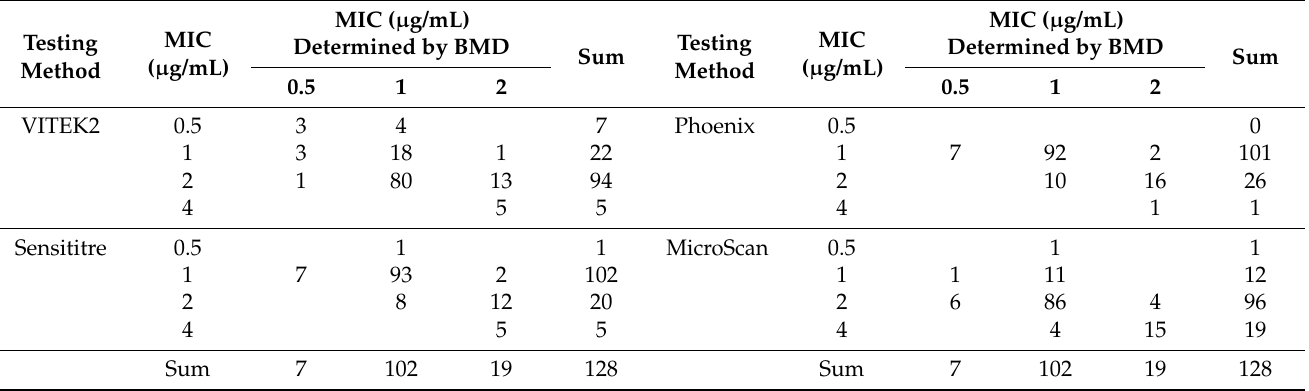
Table 3. Distribution of vancomycin MICs determined by different antimicrobial susceptibility testing methods compared to broth microdilution (BMD).